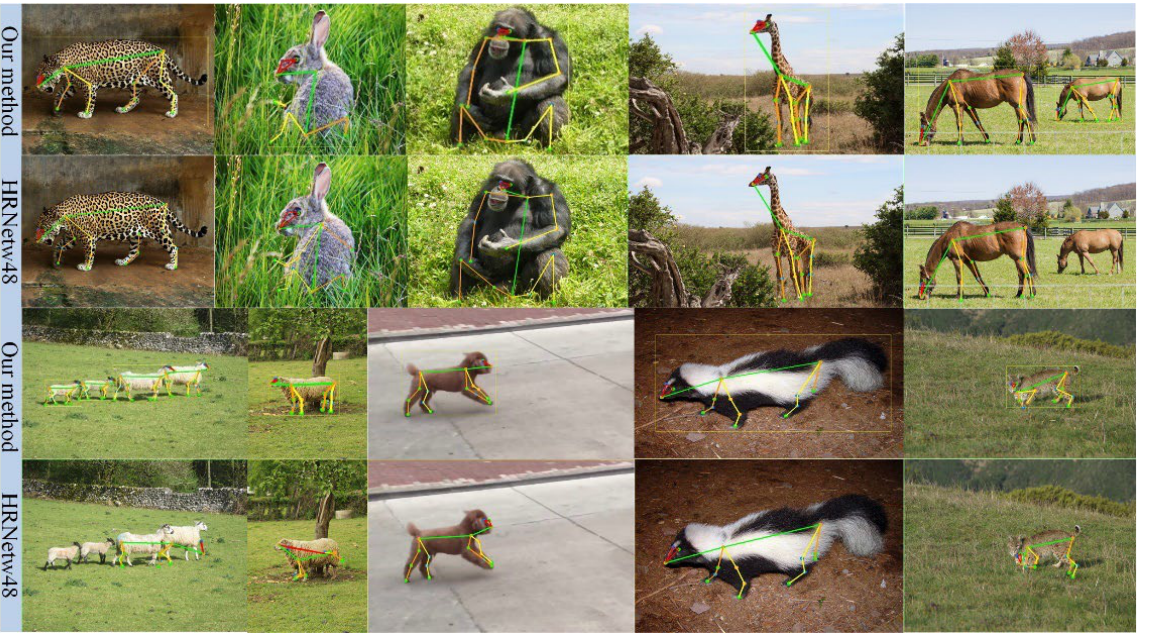
Figure 10. Some qualitative results of our method (the odd rows) vs. original HRNet-w48 (the even rows) on